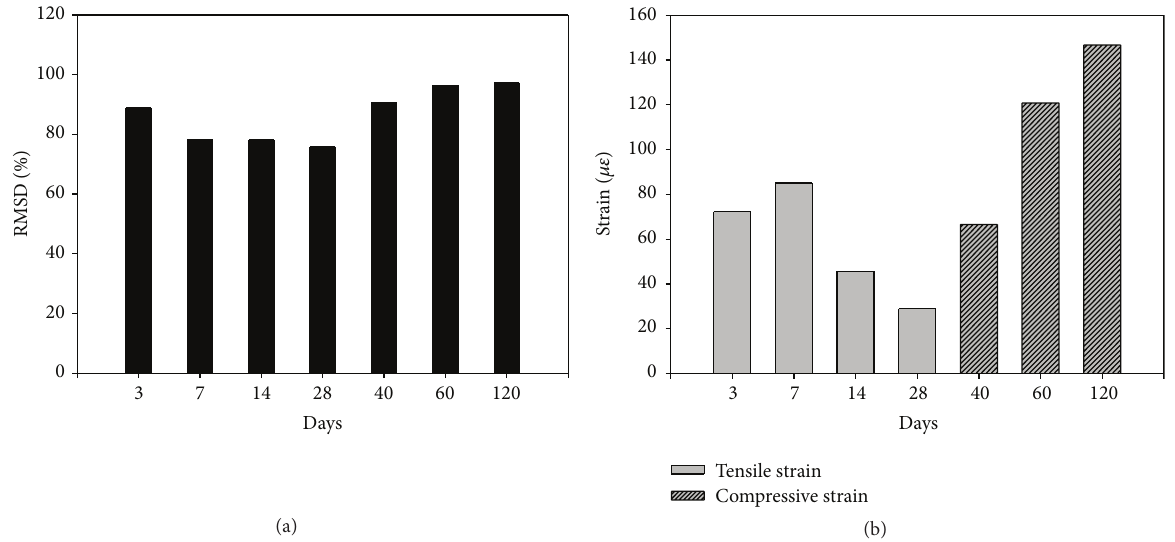
Figure 19: Measurements for PZT2: (a) RMSD value and (b) strain of concrete around EMI